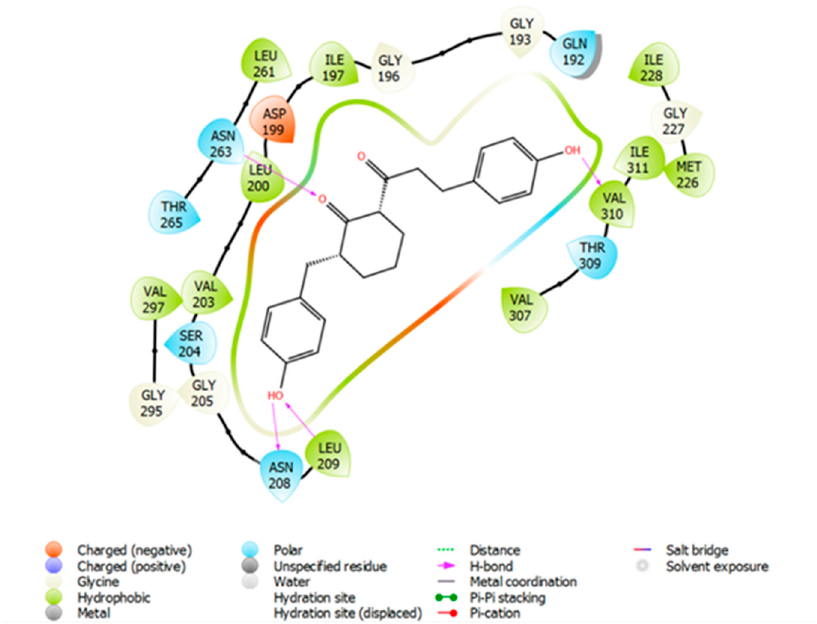
Figure 10. A 2D view of compound 3 docked into the PC190723 4 binding site of FtsZ (PDB ID 4DXD).